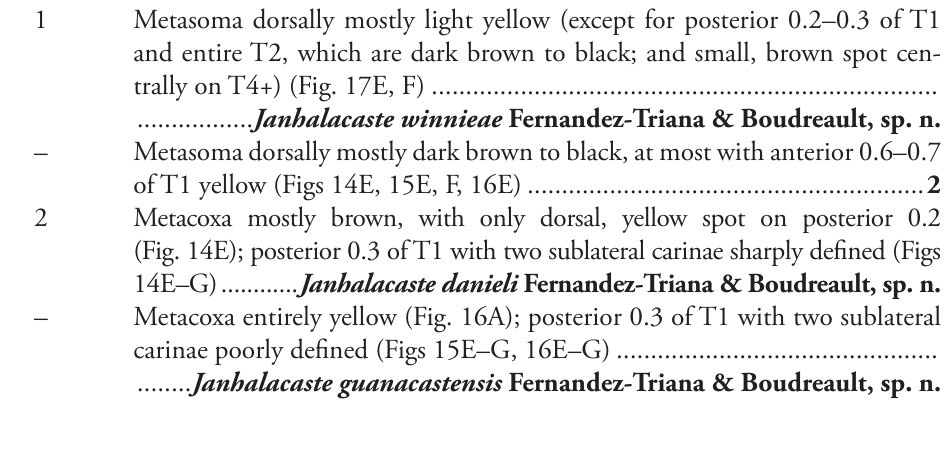
Fig. 14 Holotype. Male, Costa Rica, CNC. Holotype labels. COSTA RICA: Guanacaste,/ACG, Sector Pitilla,/Medrano, 380m,/11.01602, -85.38053,/02/06/2012/DHJPAR0049240. Holotype locality. COSTA RICA, Guanacaste, Area de Conservación Guan- acaste, Sector Pitilla, Medrano, 380m, 11.01602, -85.38053. Diagnosis. This is the only species in the genus with dark (brown)